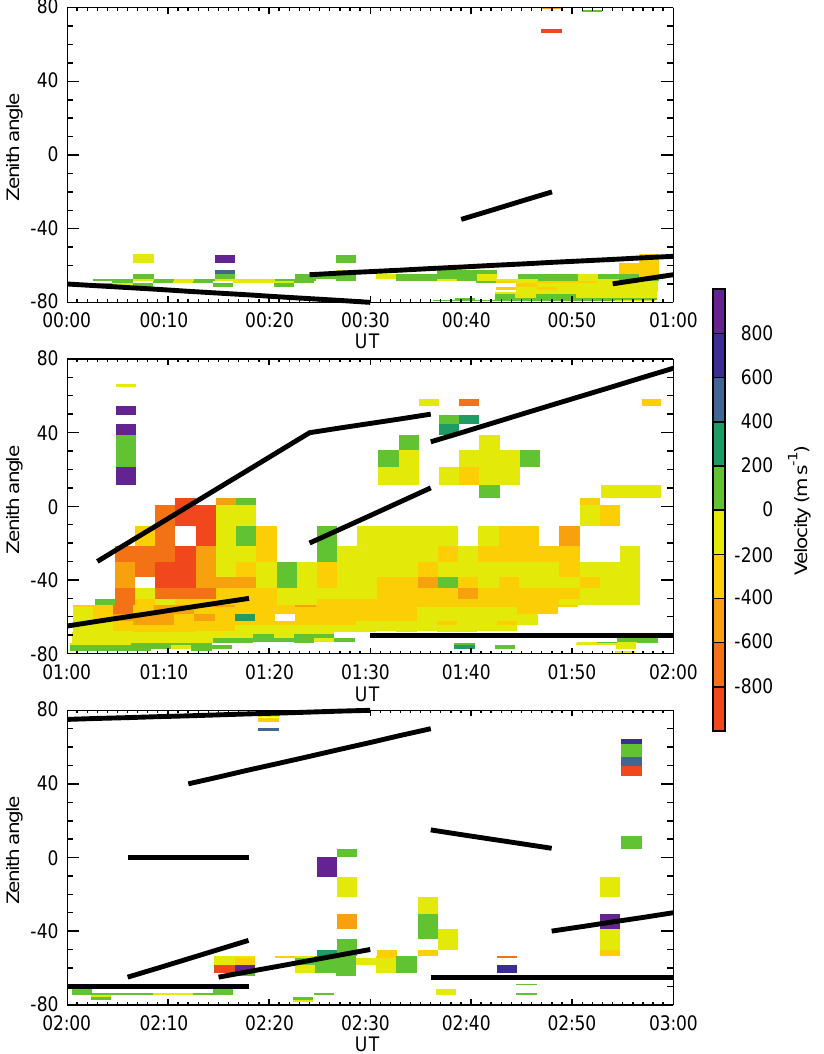
Fig. 3. The variation in zenith angle of optical features along the MSP meridian during the interval 00 UT and 03 UT ( dark lines ); the poleward progressing feature is predominantly seen between 0100 UT and 0230 UT. Also superimposed on these axes is the projection of line-of-sight backscatter velocities measured by the CUTLASS Fin- land radar along the MSP meridian for a projection altitude of